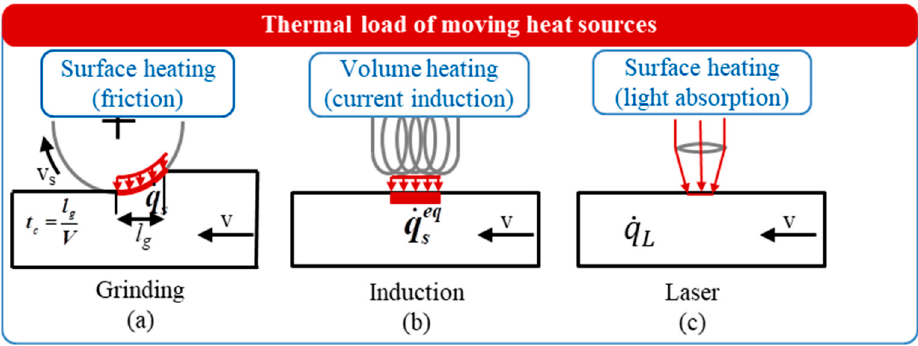
Figure 1. Basic models of external thermal loads due to grinding ( a ), induction ( b ) and laser heating ( c